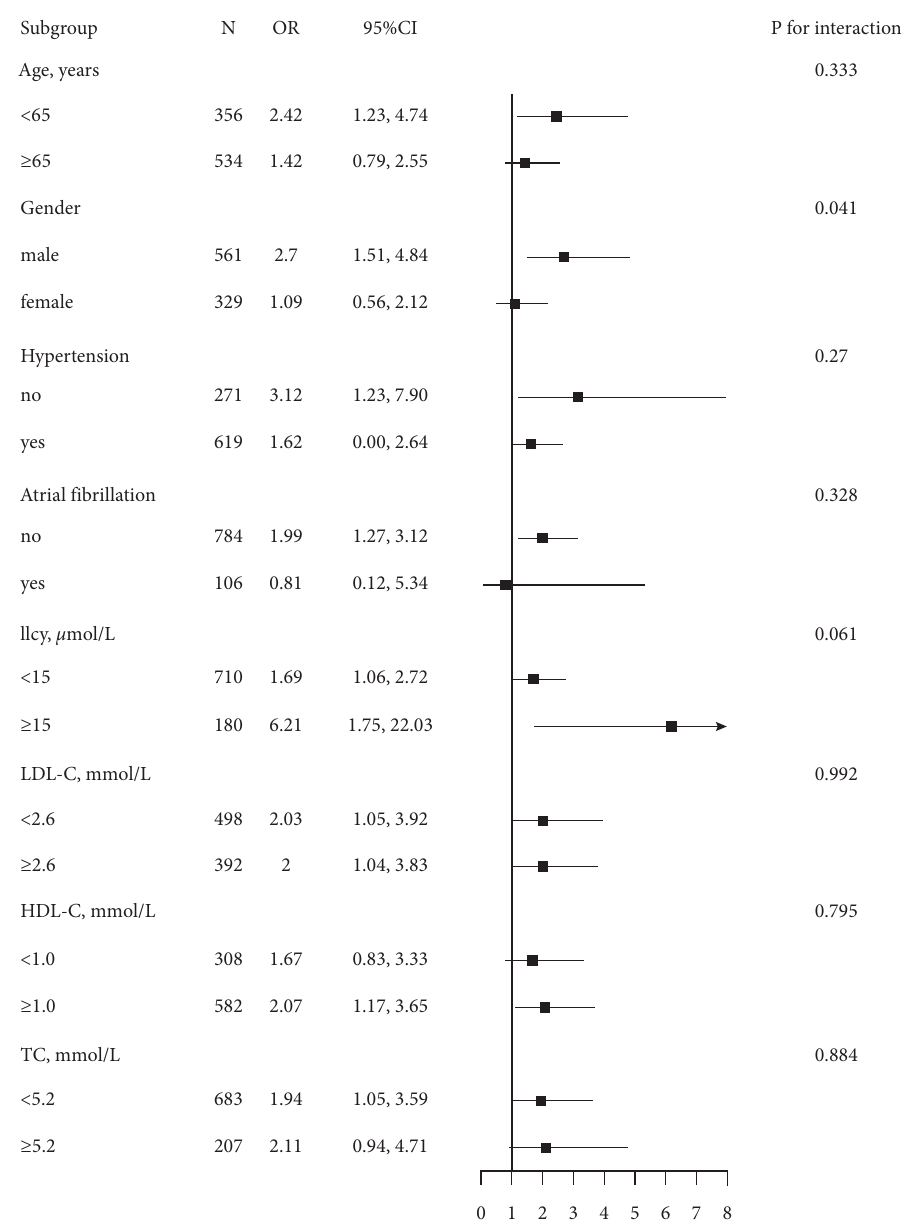
Figure 3: Subgroup analyses of the association between TRL-c and DM. Adjusted for age, gender, BMI, current smoking, SBP, Hcy, history of hypertension and atrial fbrillation, and antihypertensive drugs, if not